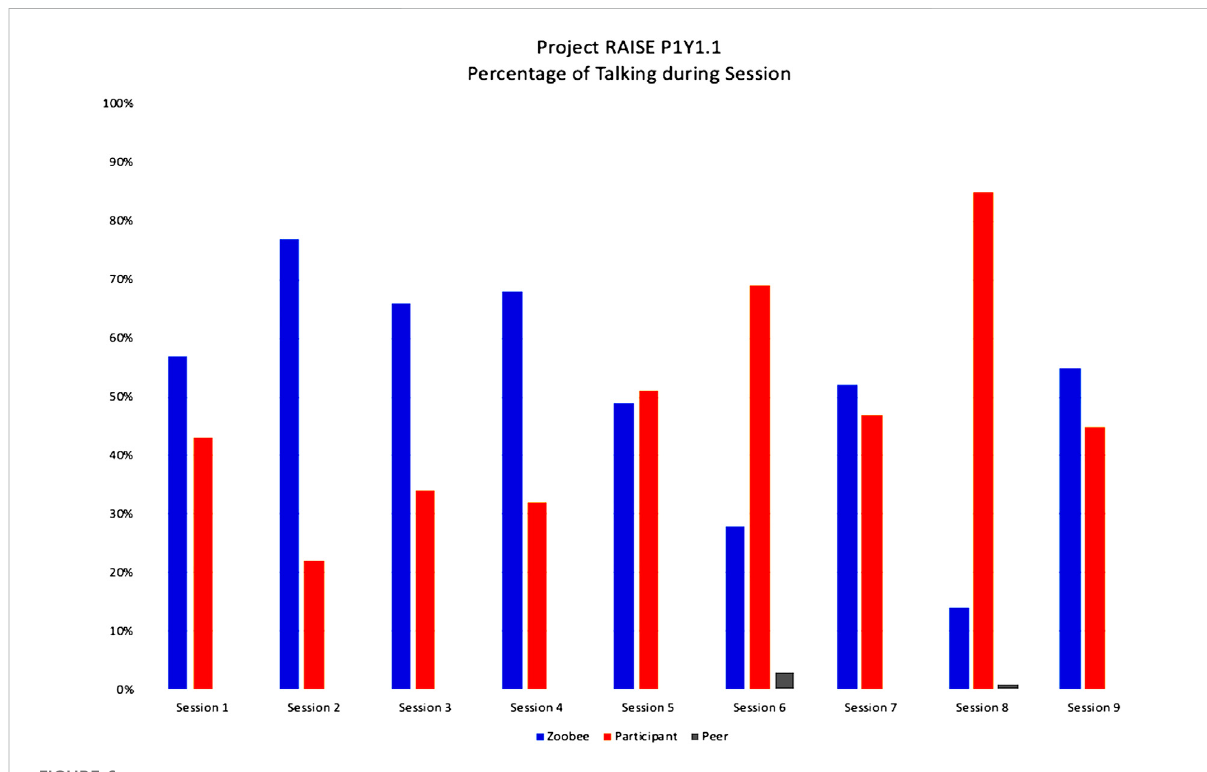
FIGURE 6 Participant 1 percentage of